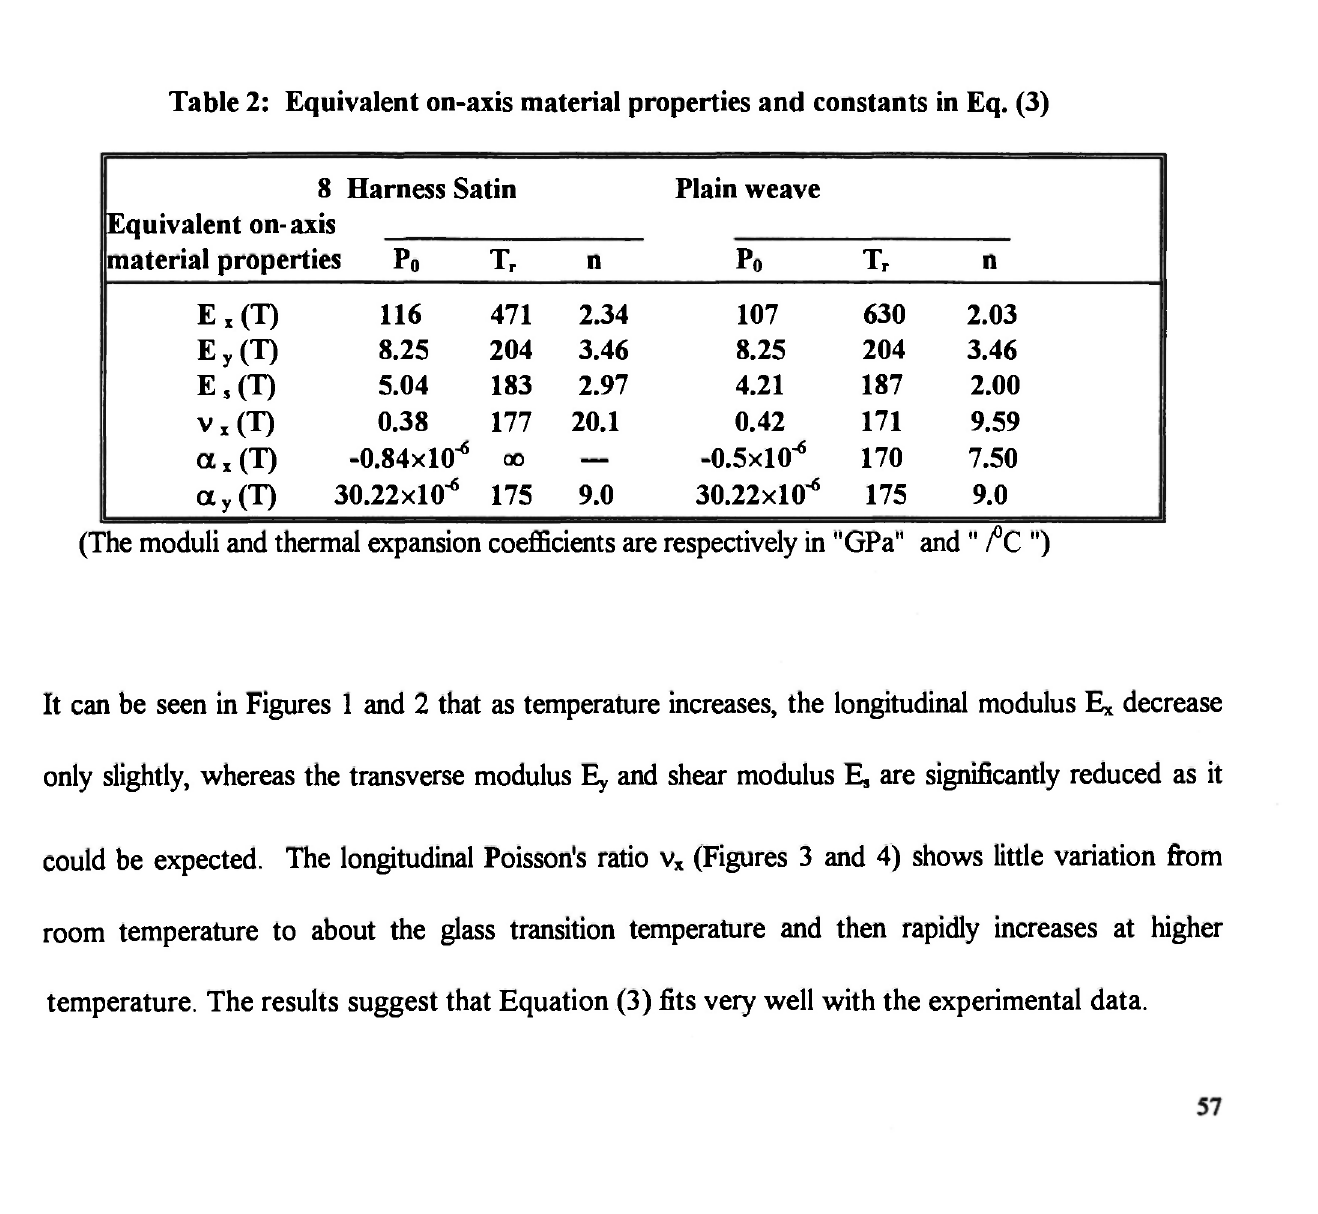
Table 2: Equivalent on-axis material properties and constants in Eq. (3) 8 Harness Satin Plain